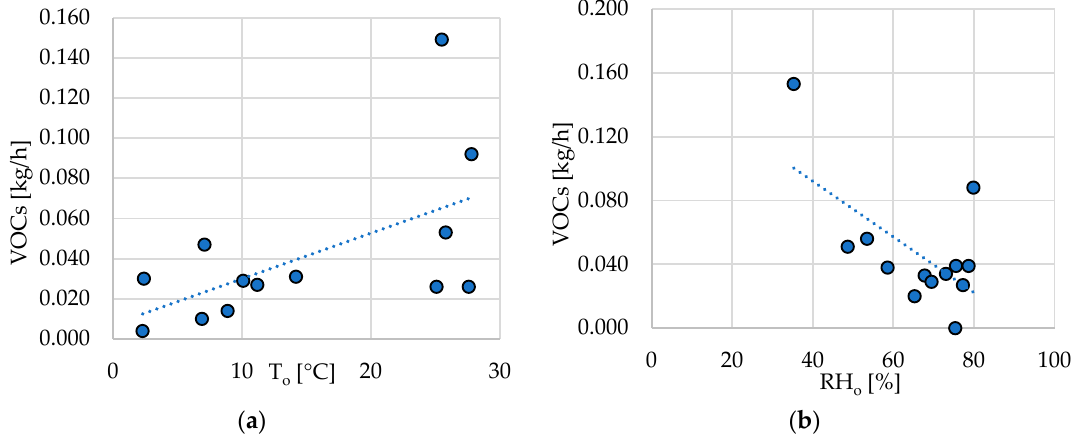
Figure 16. Correlation diagrams between VOC emission from biofilters at biogas plants and measured microclimatic parameters, with regression lines: ( a ) biogas plant A R 2 = 0.39, ( b ) biogas plant B R 2 = 0.33.